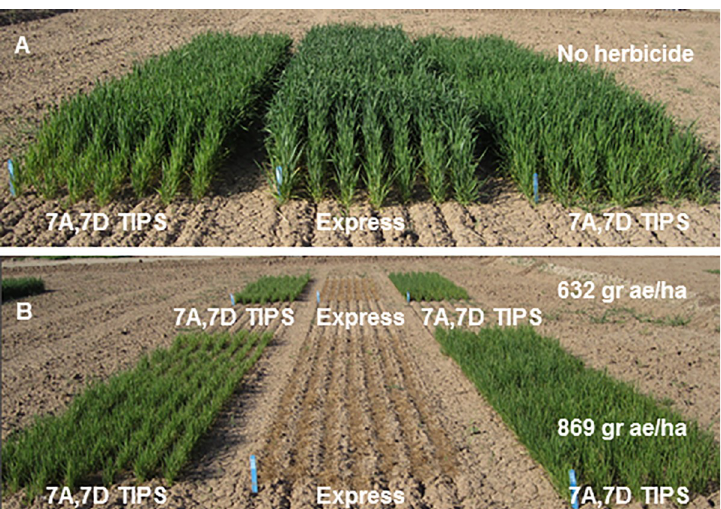
Fig 6. Field plots of wild type and TIPS allele containing lines without (A) and with (B) glyphosate herbicide treatment. In both panels A and B, the middle plot consists of the parental “Express” cultivar, while left and right plots are two separate lines containing chromosome 7A and 7D TIPS alleles (genotype III in Fig 3B). Panel A represents unsprayed plots, while in the foreground of panel B, plots were sprayed with the equivalent of 869 grams acid equivalent/hectare Roundup PowerMAX 1 . Plots in the background of panel B were sprayed with the equivalent of 632 grams acid equivalent/hectare Roundup PowerMAX 1 .